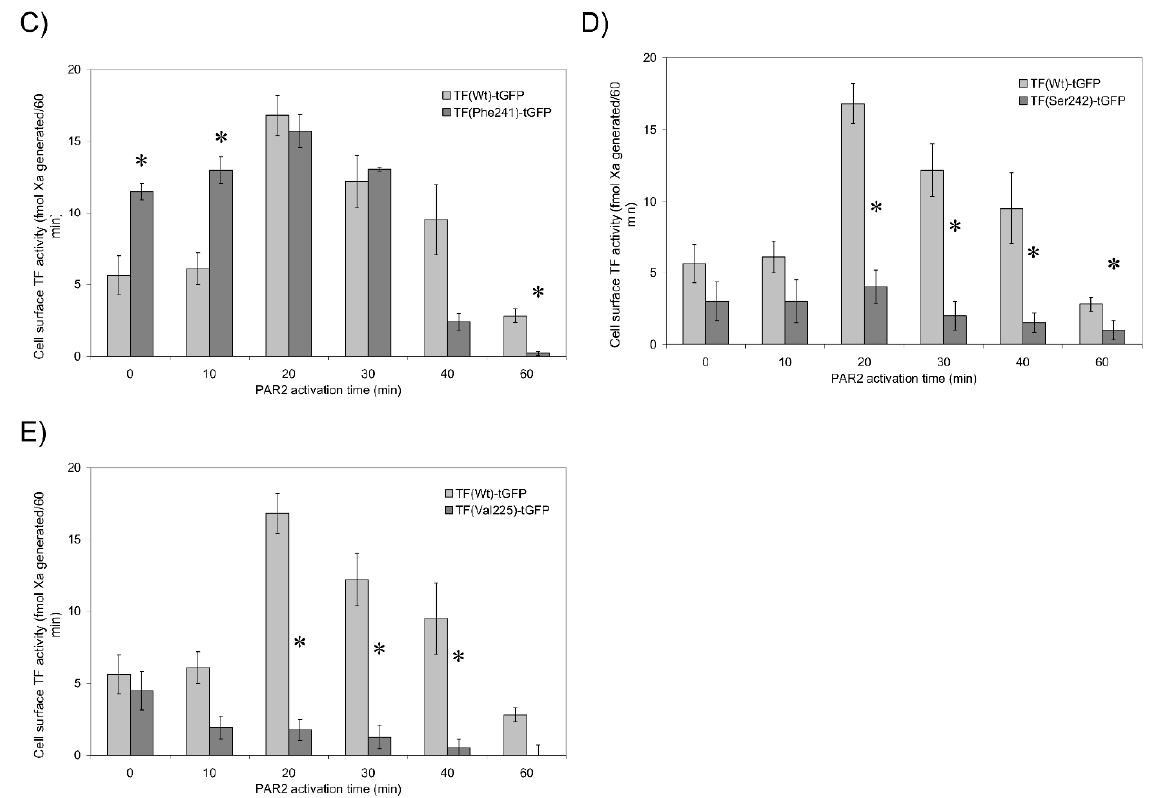
Figure 4. The influence of the modifications of TF transmembrane domain on TF activity. HDBEC (5 × 10 4 ) were transfected to express ( A ) TF ShortTM -tGFP, ( B ) TF LongTM -tGFP, ( C ) TF Phe241 -tGFP, ( D ) TF Ser242 -tGFP or ( E ) TF Val225 -tGFP, and fXa-generation was measured. ( n = 4, * = p < 0.05 vs. the respective cells expressing TF Wt -tGFP.)